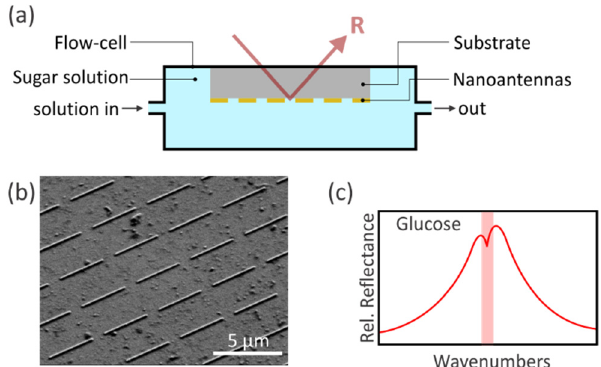
Figure 2. ( a ) Reflection flow-cell for FTIR spectroscopy in aqueous environments. Tubing allows to flush the desired aqueous solution through the flow cell. The nanoantennas are fabricated on top of an infrared transparent CaF 2 substrate and are immersed in the aqueous environment. Incident infrared light excites the plasmonic resonances of the nanoantennas, which are resonantly matched with the vibrational modes of the five sugar molecules. The SEIRA spectra are obtained by the detection of the reflected light. ( b ) SEM image of the gold nanoantenna array (200 µ m × 200 µ m). The nanoantenna length is 3400 nm with a period of 4400 nm in x - and 3000 nm in y -direction. The x -direction ( y -direction) is along the long (short) antenna axis. The width and thickness are adjusted to 100 nm. Additionally, a 2 nm chromium adhesion layer is on top of the CaF 2 substrate. ( c ) Sketch of the enhanced molecular vibration of the glucose molecule on top of the plasmon resonance in relative